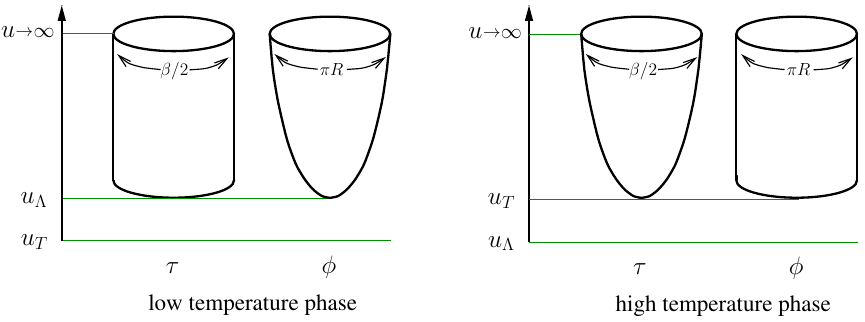
Figure 1 . The topology of the solutions which dominate in the low temperature (confined) and high temperature (deconfined) phases of the compactified D3 brane model, as reflected in the ( τ, u ) and ( φ, u )